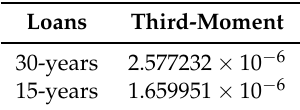
Table 3. Skewness of the return